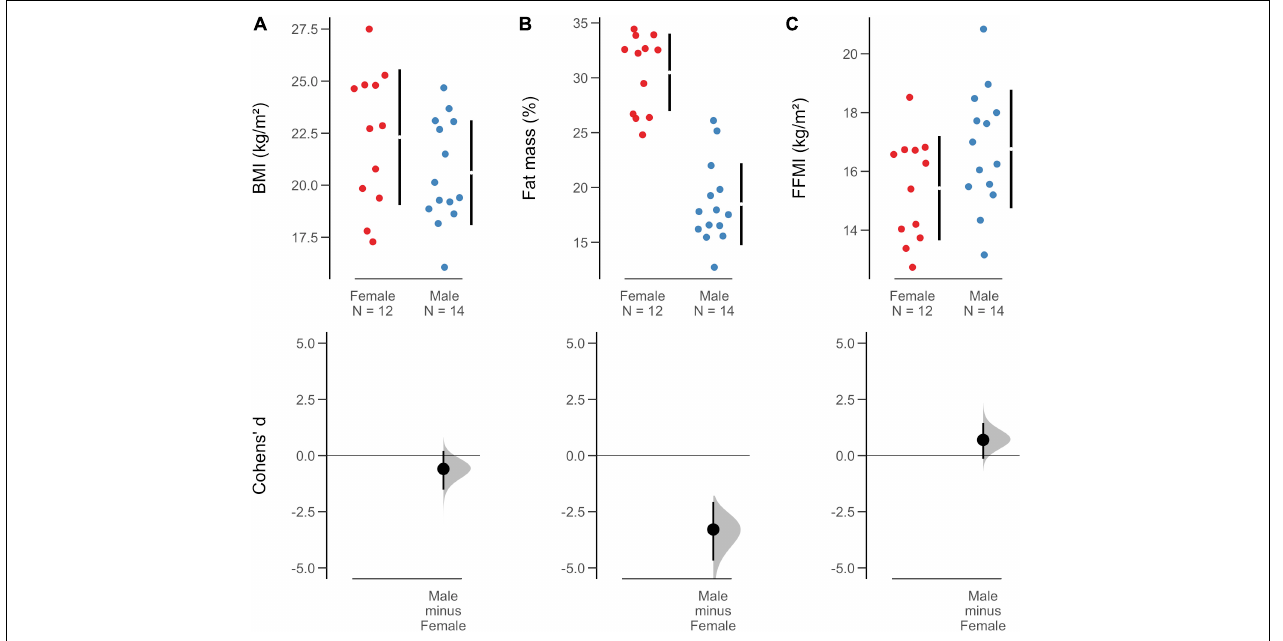
FIGURE 2 | Differences in body composition parameters compared by sex and respective effect sizes. (A) Body mass index (BMI); (B) fat mass; (C) fat-free mass index (FFMI). The dispersion of the sample by sex and the size of the effect through Cohen’s d (ES) are shown. 95% confidence intervals for ES were calculated using bootstrap resampling with 5,000 replications. They are also bias-corrected and accelerated (BCa).